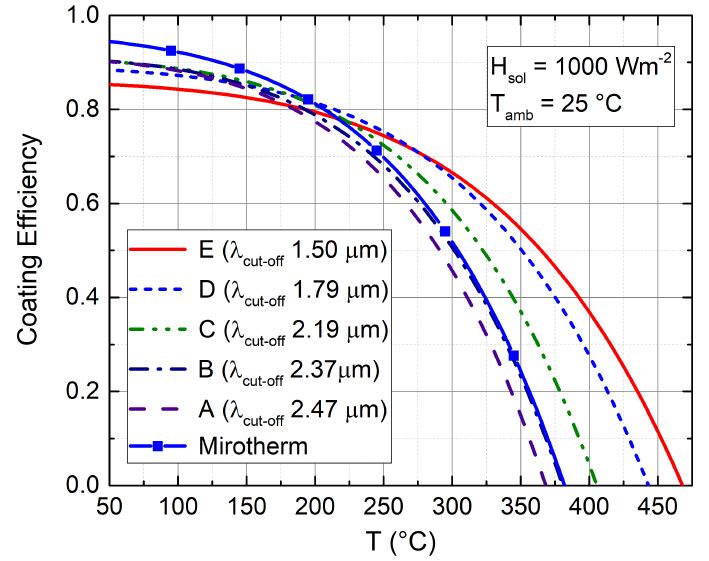
Figure 5. Absorber efficiency versus operating temperature for five multilayer absorbers with different λ cut − of f optimized for different temperatures, and Mirotherm ® commercial absorber (blue line with square